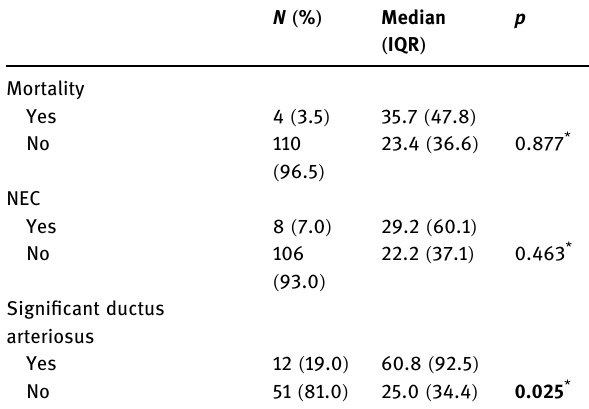
Table 3: Association of laboratory values and